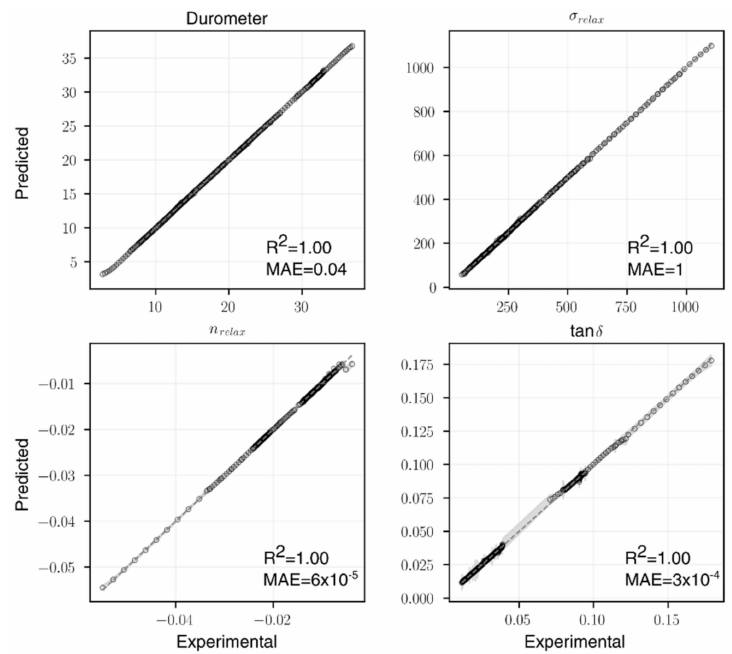
Figure 34. The parity plots describing Predicted vs. Experimental for